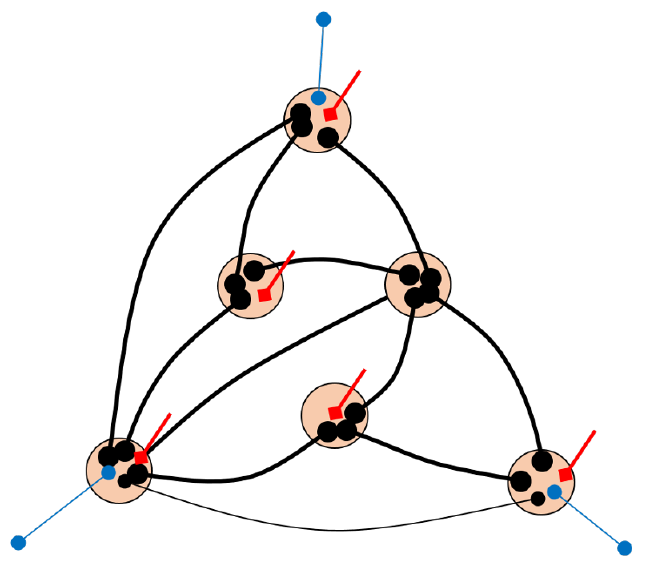
Figure 1 . An example of random tensor